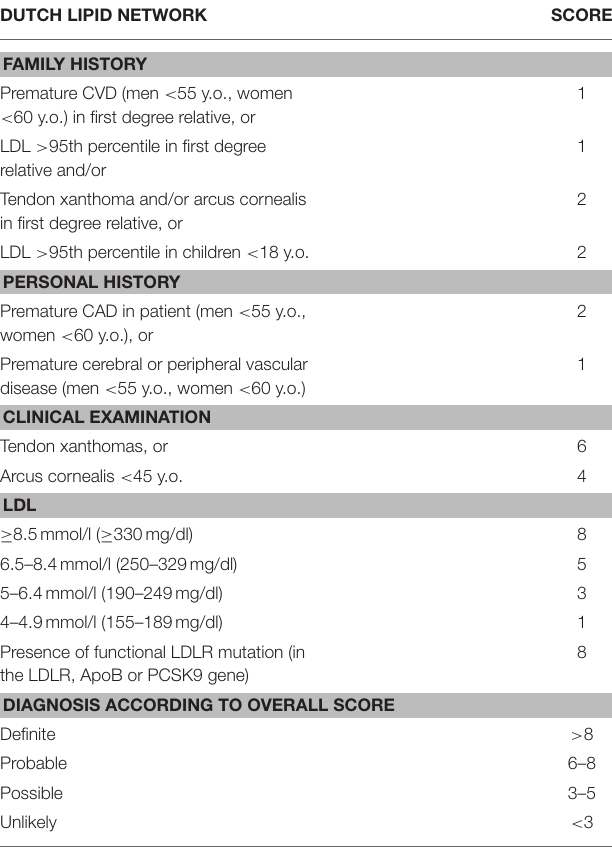
TABLE 6 | Japanese diagnostic criteria for familial hypercholesterolemia. Japanese diagnostic criteria for